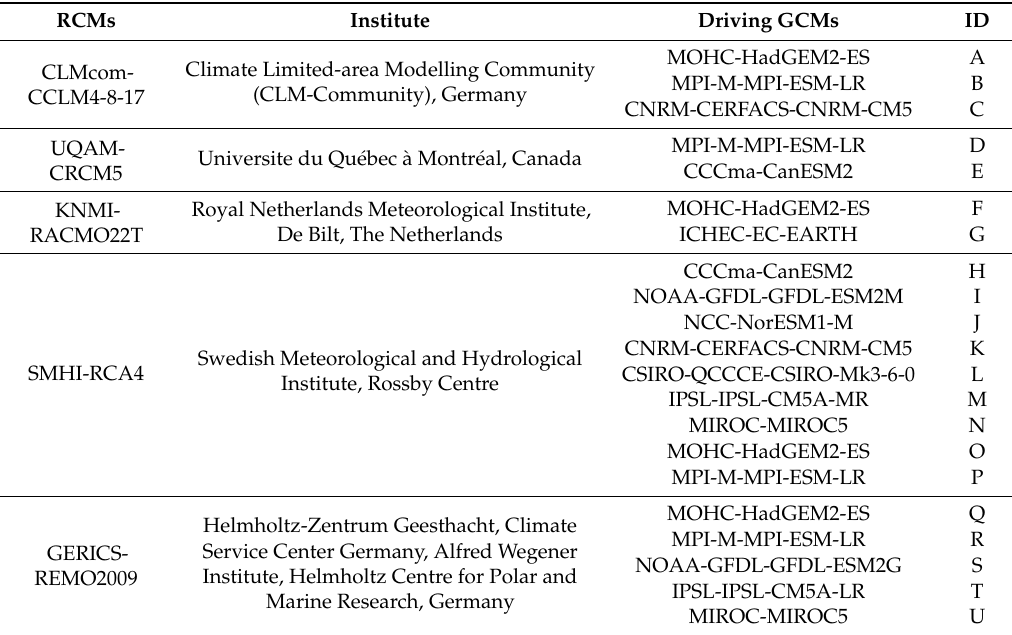
Table 2. List of the regional climate models that were evaluated in this